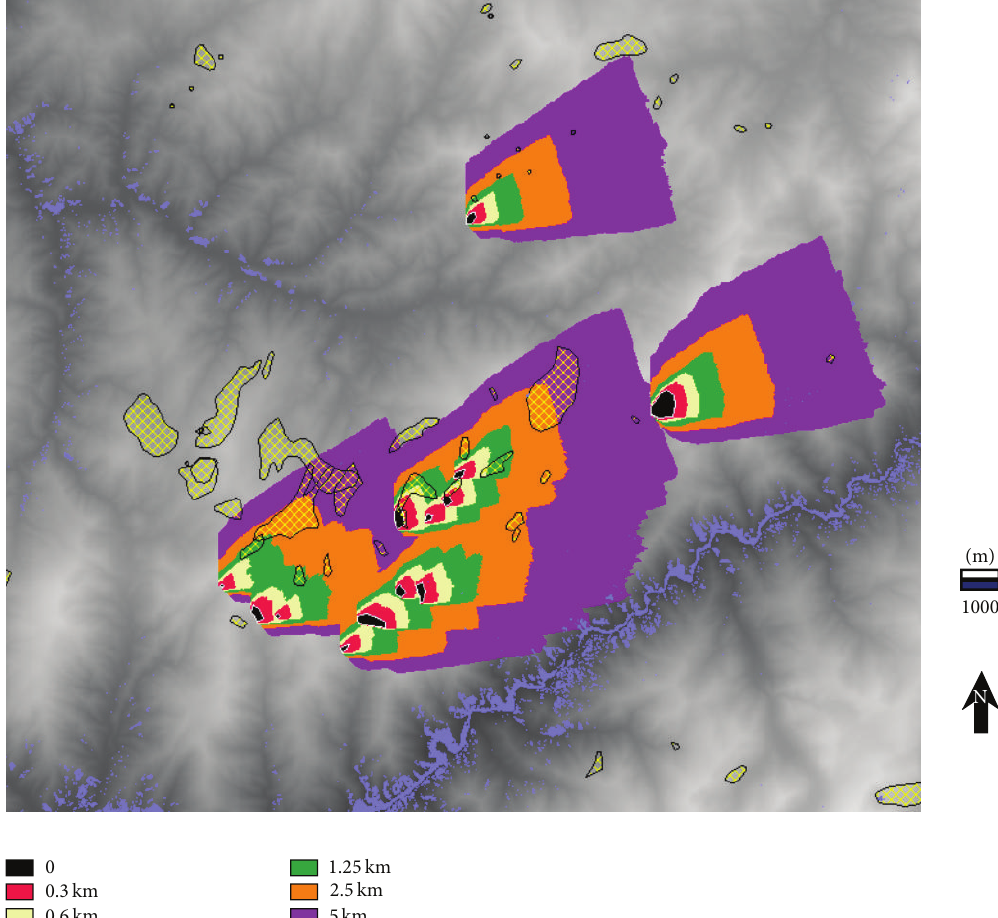
Figure 5: August wind dispersal model showing BWA (yellow crosshatched = BWA infestations found 12 to 16 years after initial survey, blue represents areas unlikely to support subalpine fir, and background layer is